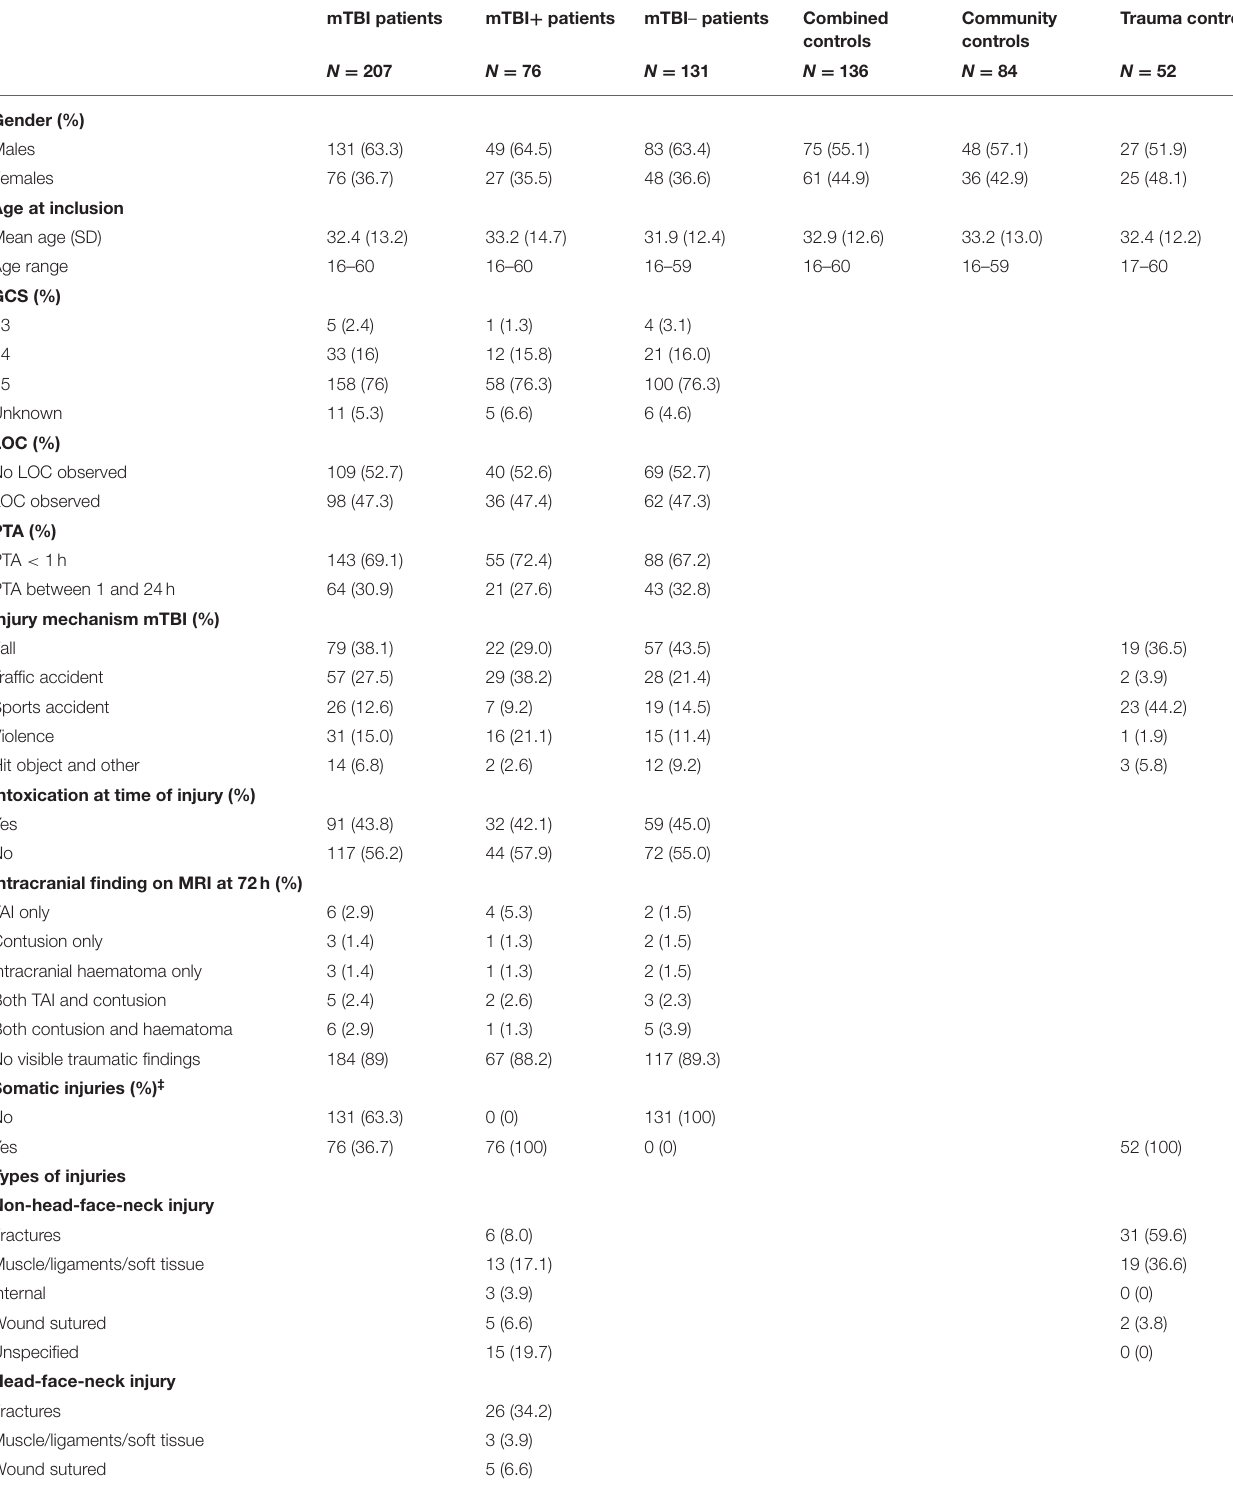
TABLE 1 | Characteristics of total number of participants included in the